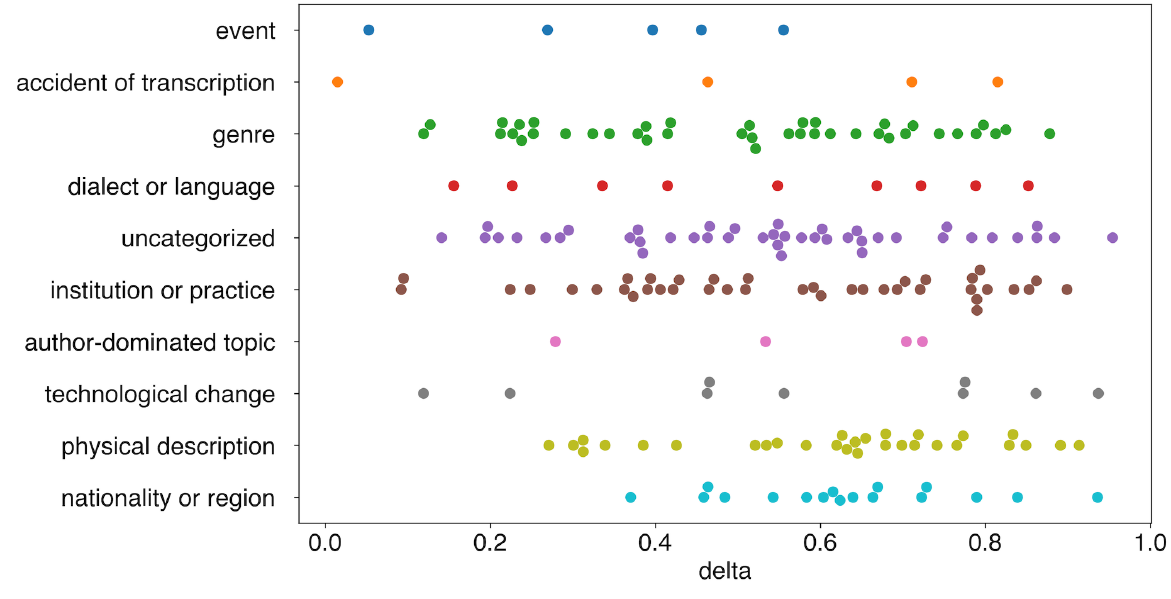
Figure 1: The delta parameters for different topic categories; total n = 200. When δ is greater than 0.5, topic prominence is more effectively explained by birth cohort than publication date. Categories are sorted by mean δ